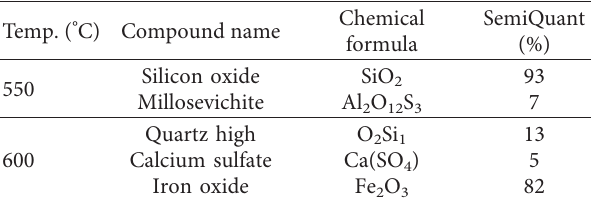
Figure 3: Comparison of 100x and 1,000x magnification of BD-1B at (a) 550 ° C and (b) 600 ° C. Table 7: XRD analysis of BD-1B